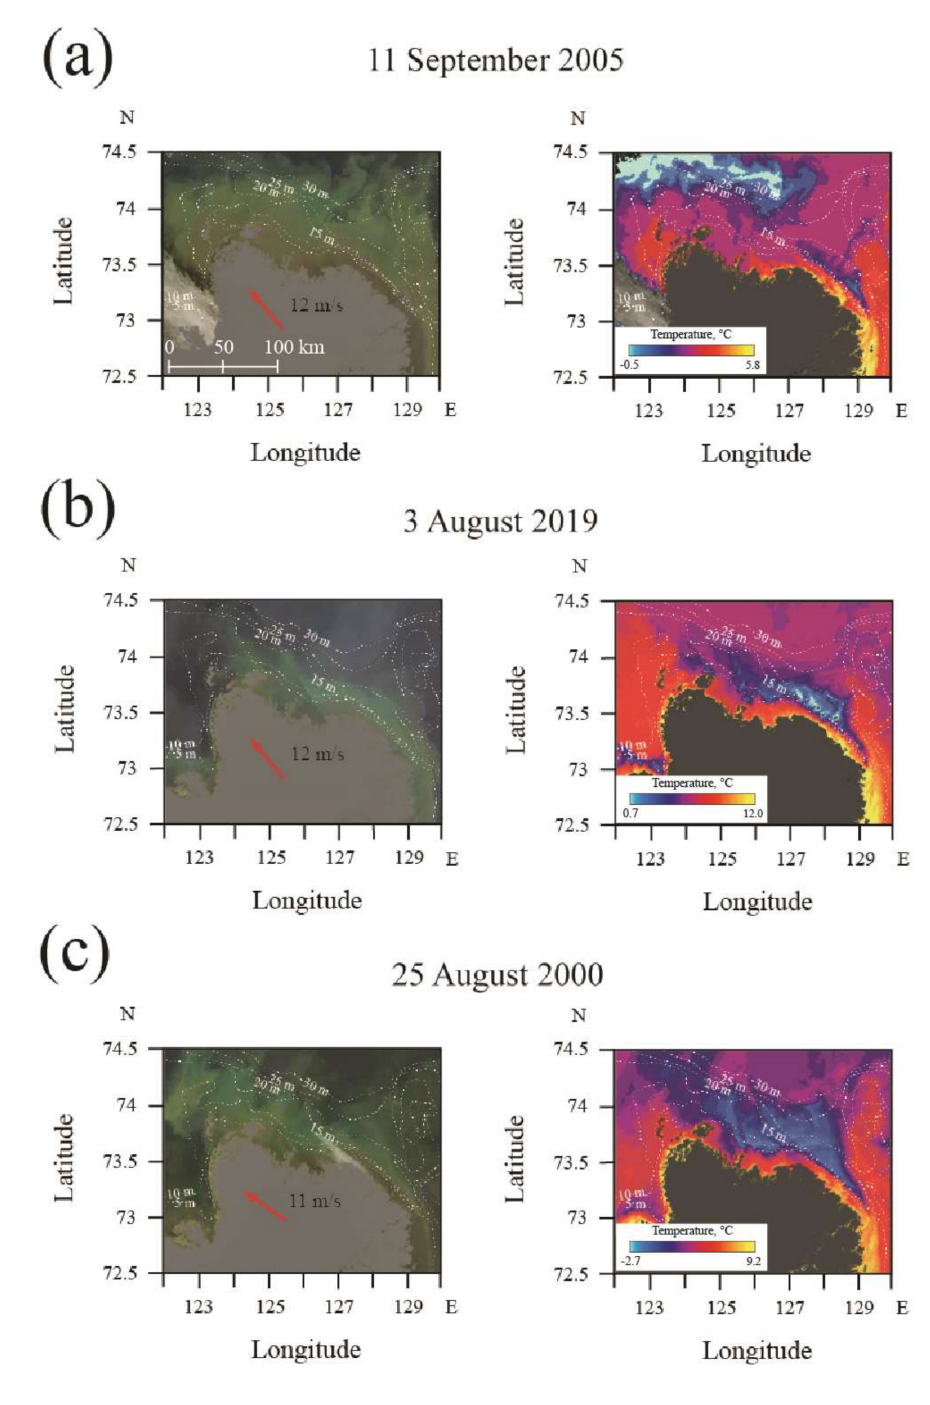
Figure 3. Corrected reflectance (left) and brightness temperature (right) from MODIS Terra and MODIS Aqua satellite images of the area adjacent to the Lena Delta acquired on ( a ) 11 September 2005, ( b ) 3 August 2019, and ( c ) 25 August 2000 illustrating initial ( a ), middle ( b ), and well-developed ( c ) stages of formation of upwelling events in response to wind forcing